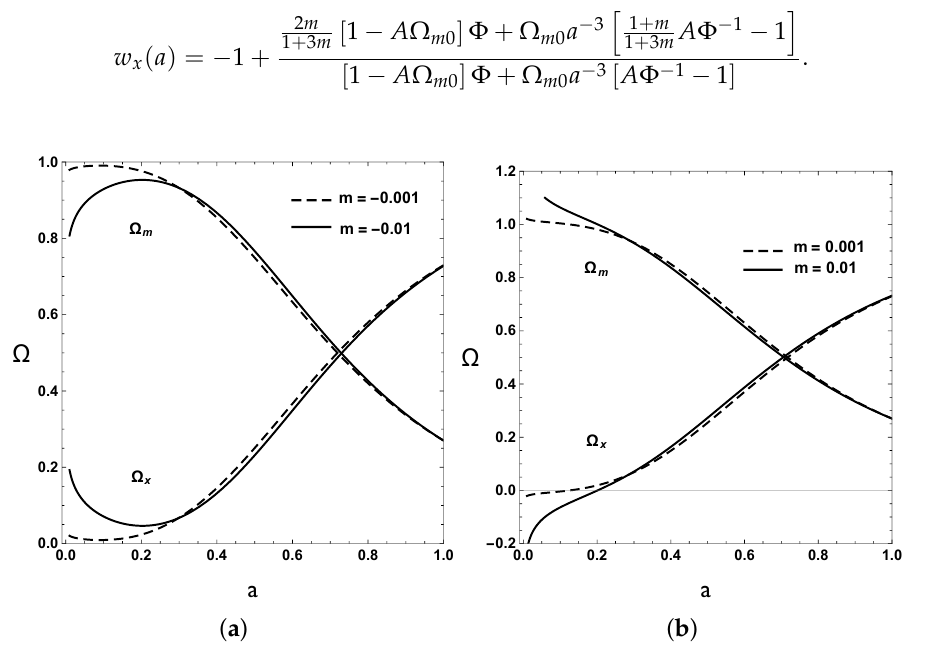
Figure 1. Matter fraction Ω m and geometric energy fraction Ω x for negative (left) and positive (right) values of m